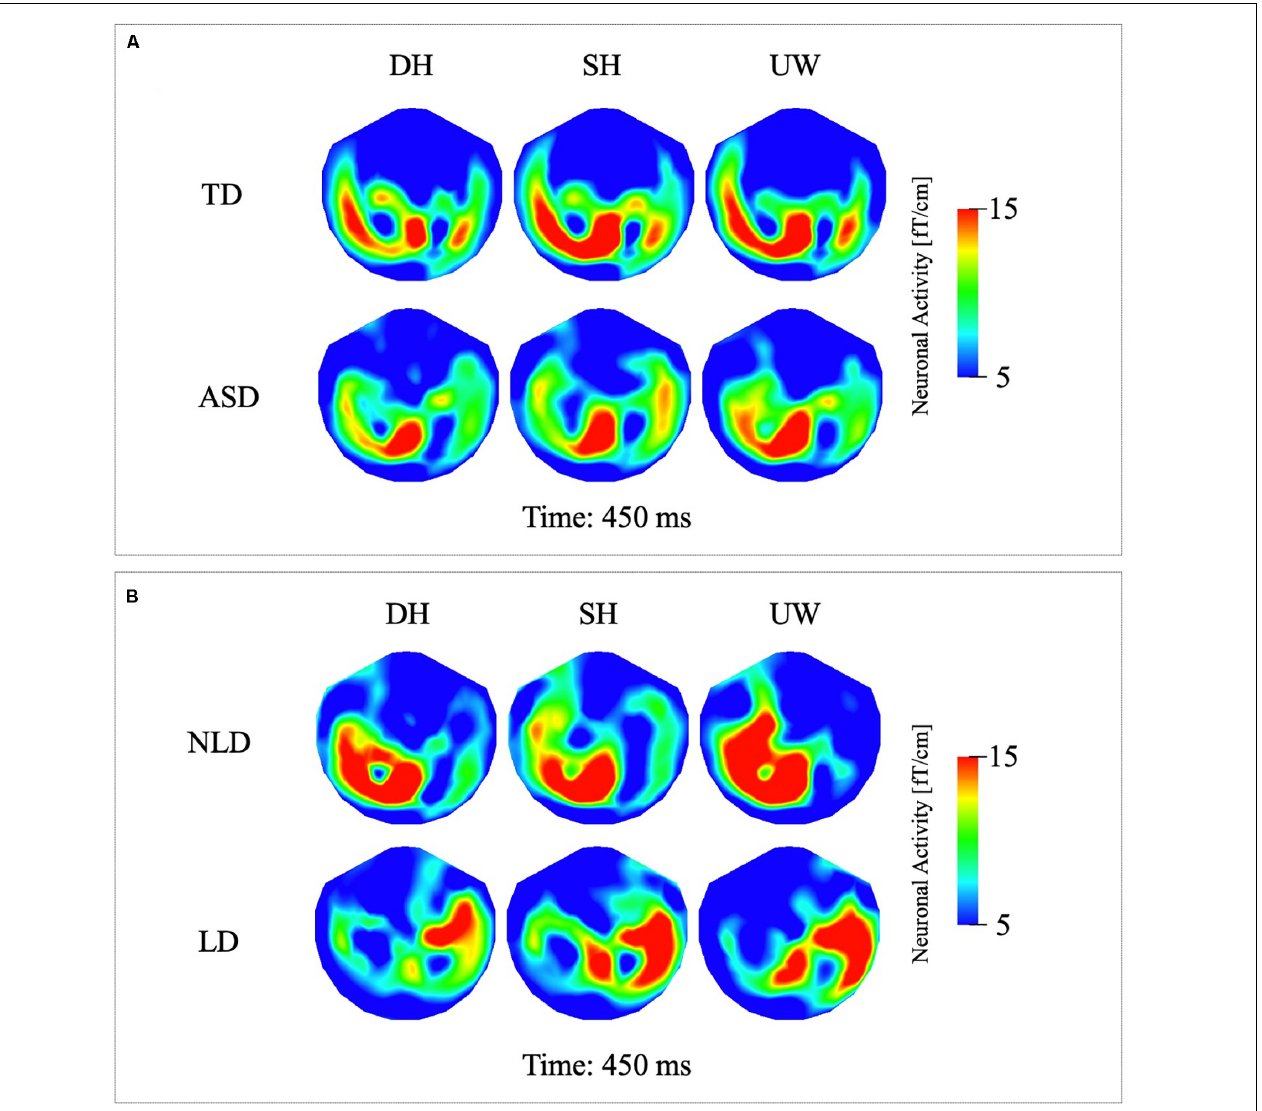
FIGURE 6 | (A) Top row: TD group’s local RMS-maps for dominant homonym, subordinate homonym, and unambiguous word at 450 ms. Bottom row: ASD group’s local RMS-maps for dominant homonym, subordinate homonym, and unambiguous word at 450 ms. (B) Top row: NLD group’s local RMS-maps for dominant homonym, subordinate homonym, and unambiguous word at 450 ms. Bottom row: LD group’s local RMS-maps for dominant homonym, subordinate homonym, and unambiguous word at 450 ms. For the presentation of data, the detectors have been projected into two dimensions (right ear on the right, front at the